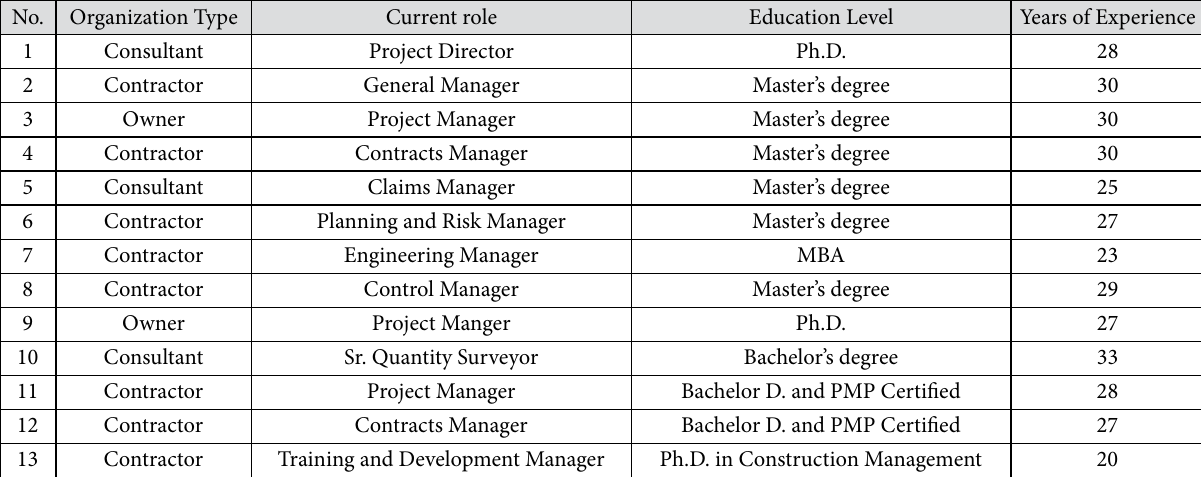
Table 2. Characteristics of the Delphi